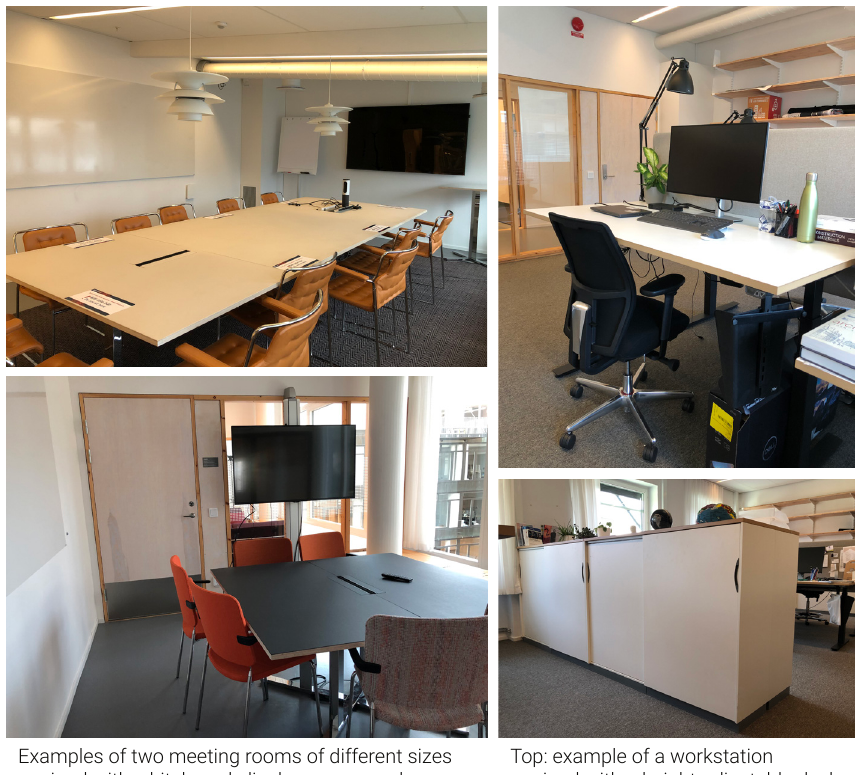
Figure 9. Access to